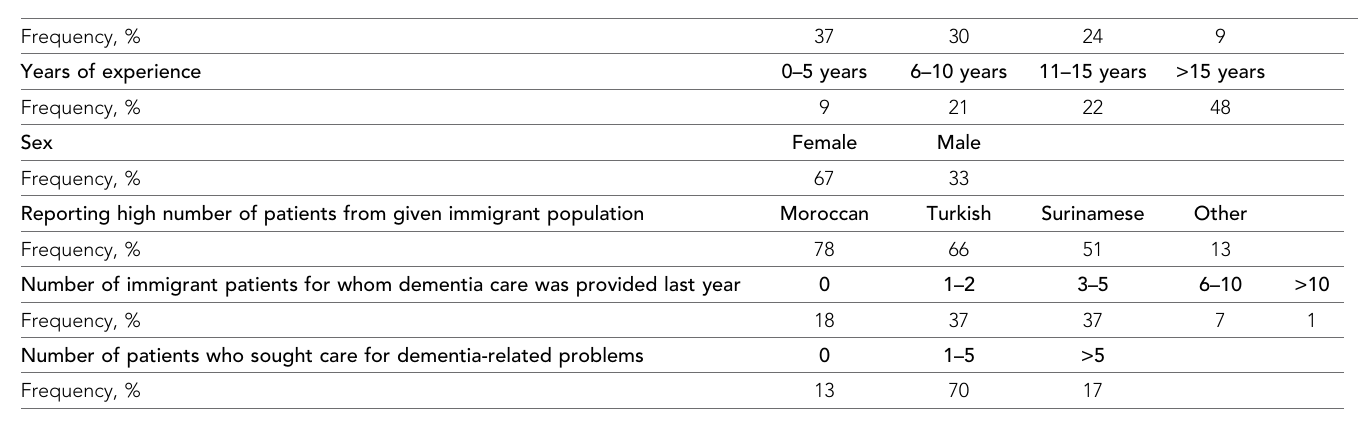
Table 1. Baseline characteristics of GPs ( n = 76) participating in the online survey Working